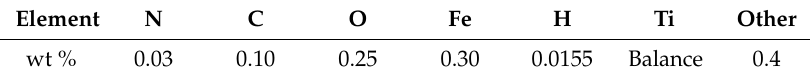
Figure 1. ( a ) The morphology of the Ankylos ® implant surface recorded at 500× magnification. The inset: the photography of the used dental implant C/X A11; ( b ) the structure of the sodium alendronate trihydrate. Table 1. Chemical composition (wt %) of titanium c.p. grade 2 [41].